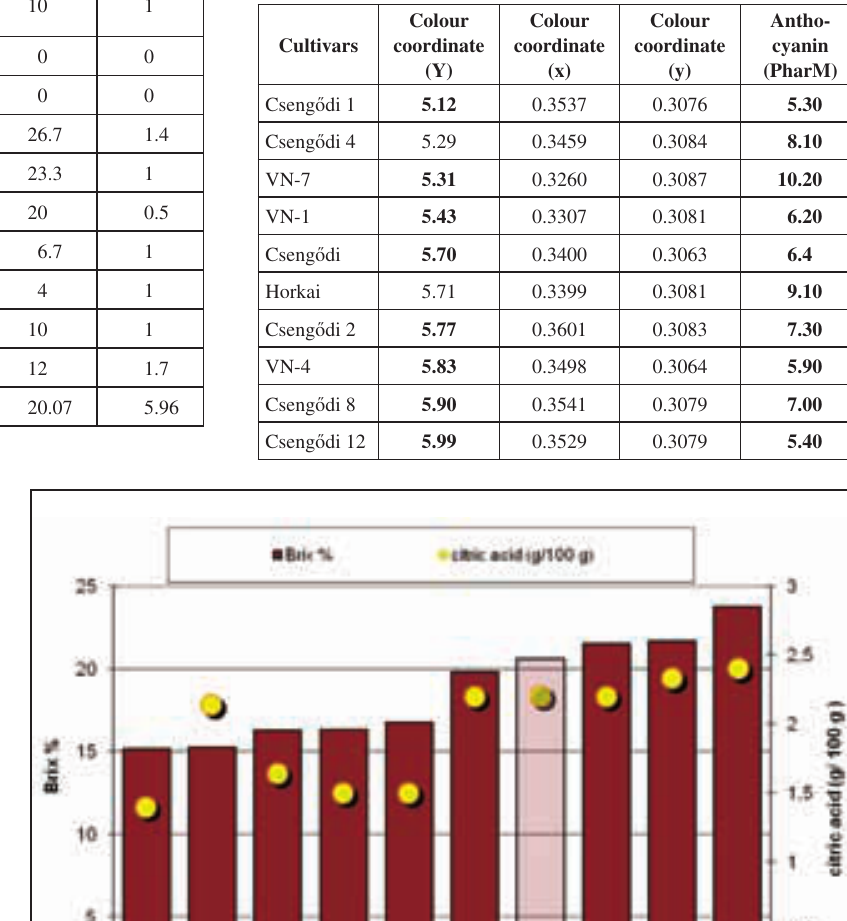
Figure 2. Flesh firmness of resistant sour cherry clones Table 3. Fruit colour and anthocyanin capacity of resistant sour cherry cultivars (Pallag-Újfehértó, 2014)